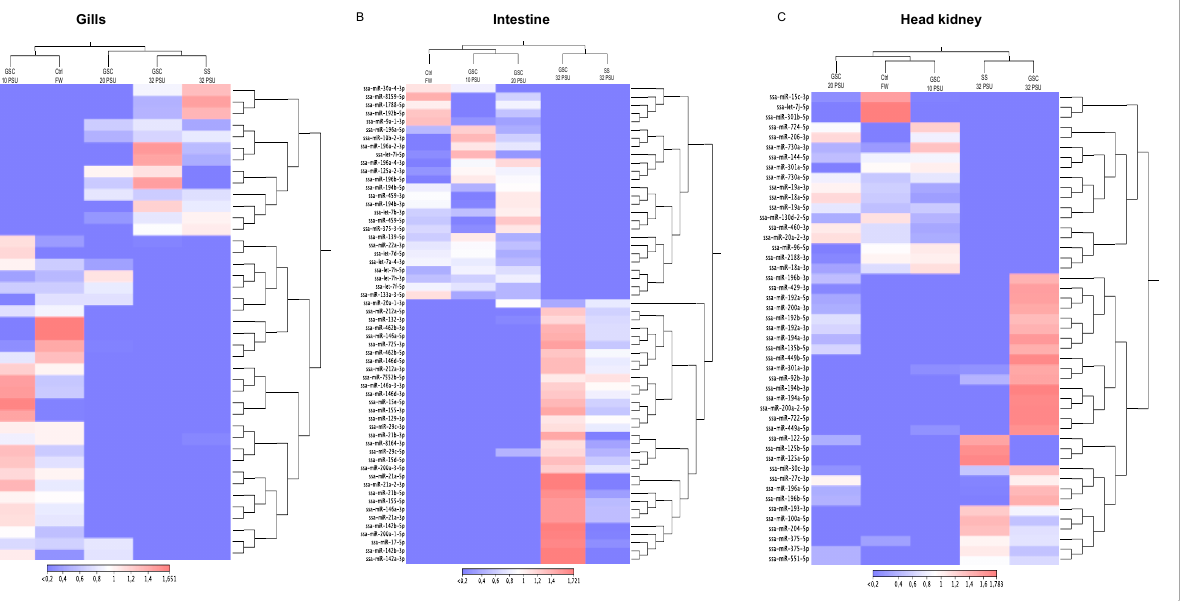
Figure 6. miRNA expression profile during gradual salinity changes and salinity shock in gills, intestine, and head kidney of Atlantic salmon.